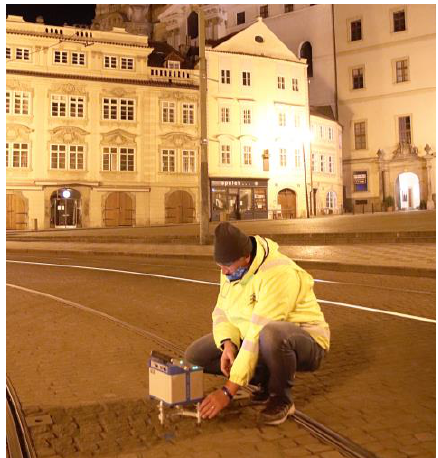
Figure 1. The gravity measurement in the centre of Prague